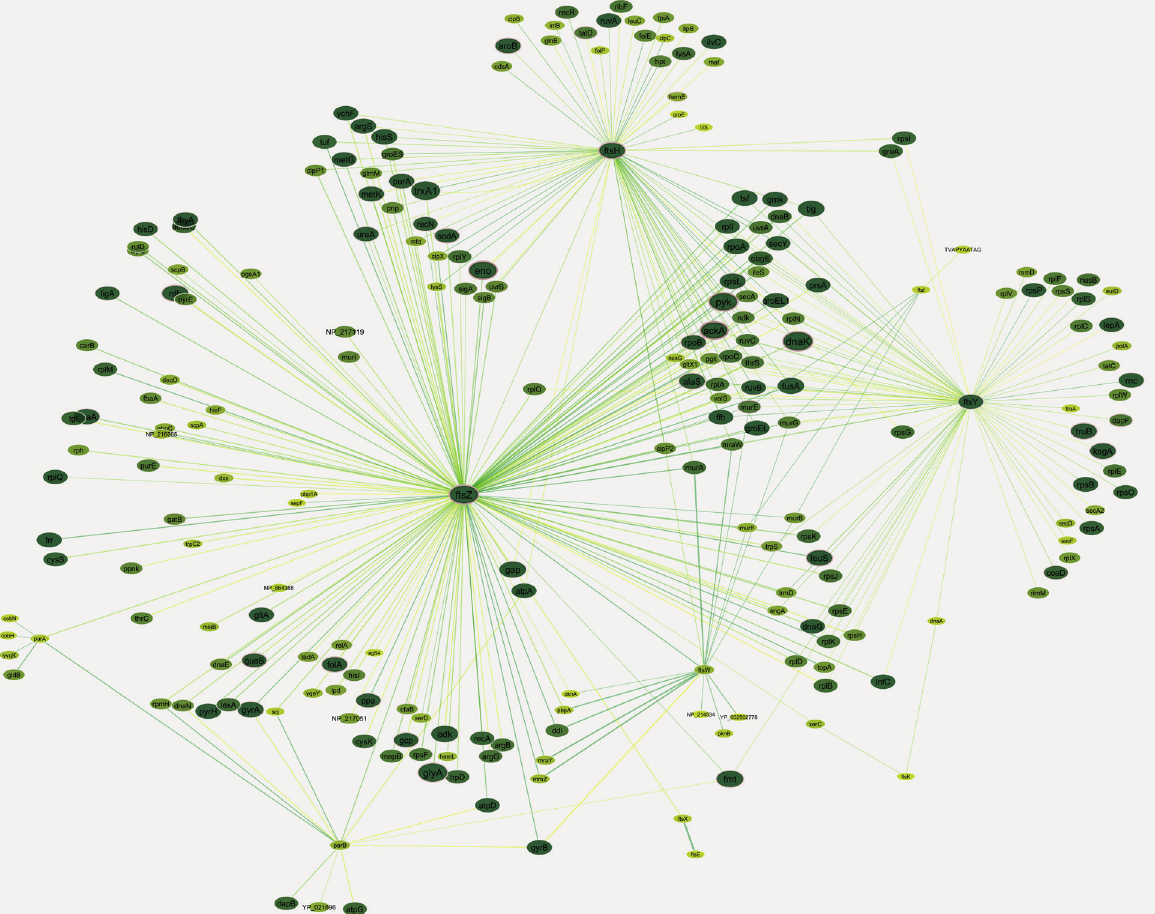
Figure 1 - The protein-protein interaction to cell division proteins of Corynebacterium. The cluster of proteins shows the large number of interactions made by FtsZ with the others fts proteins. In addition, the result shows SepF interacting with FtsZ. In yellow and green ICS> = 0.5625 (70% identity for 70% coverage at least). In red, refers to a lower value, which means less possibility of